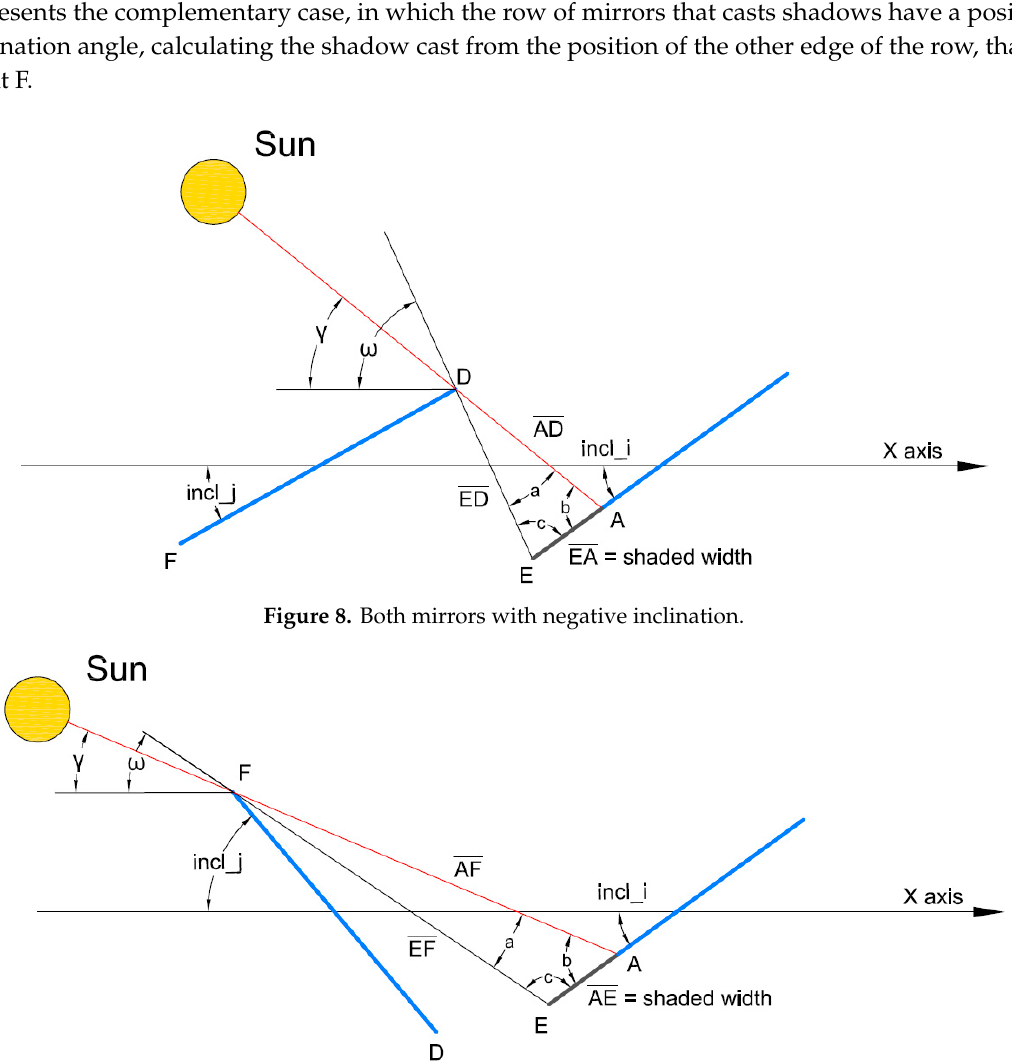
Figure 9. Mirror rows with a negative inclination and previous mirror rows with positive inclination.